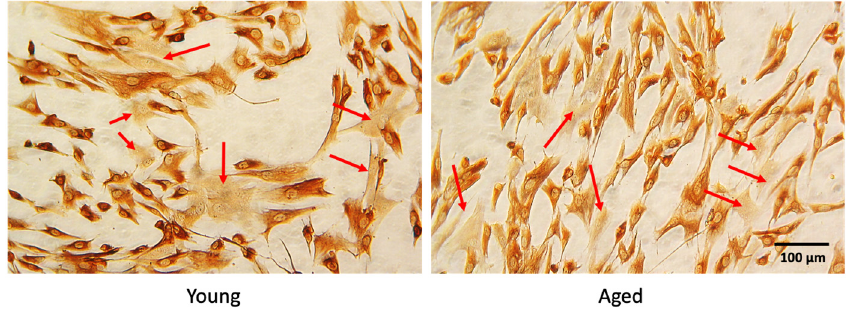
Figure 11. Representative images of desmin-positive (brown) and desmin-negative (arrows) cells obtained from young and aged subjects, viewed under an inverted microscope.